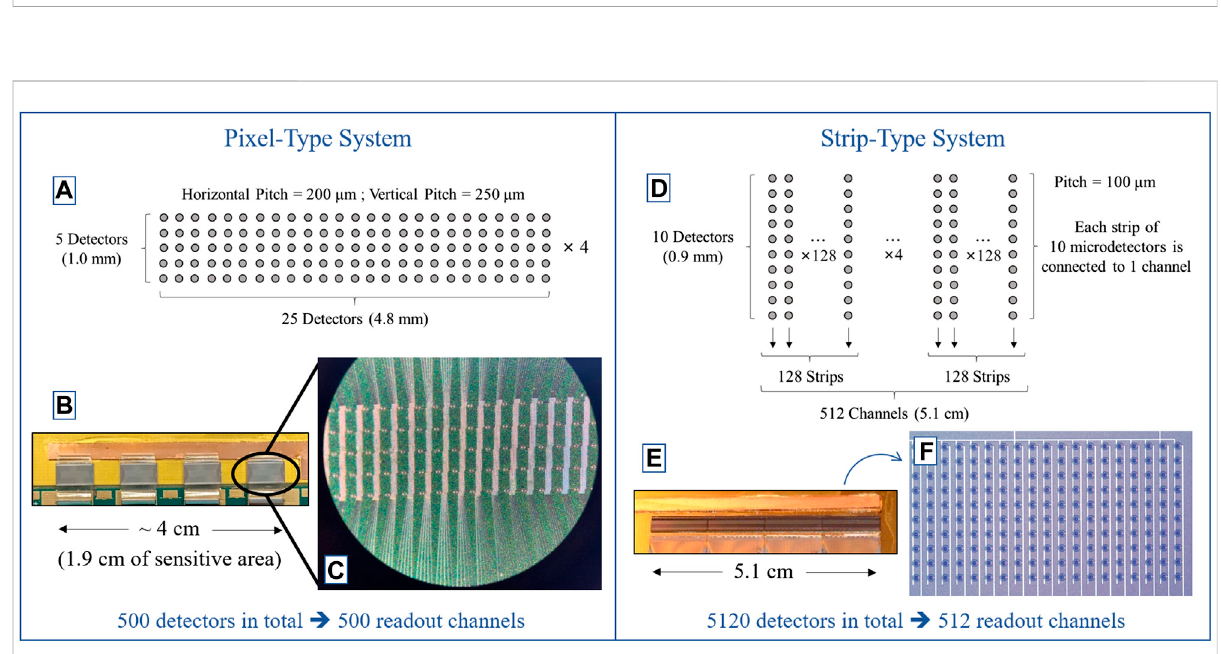
FIGURE 1 (A) SEMimageofthecrosssectionofanindividual3Dcylindricalmicrodetector. (B) Sketchofpitchdistributionsofthesemicrodetectors.Thisis a tunable parameter depending on the fi nal application.